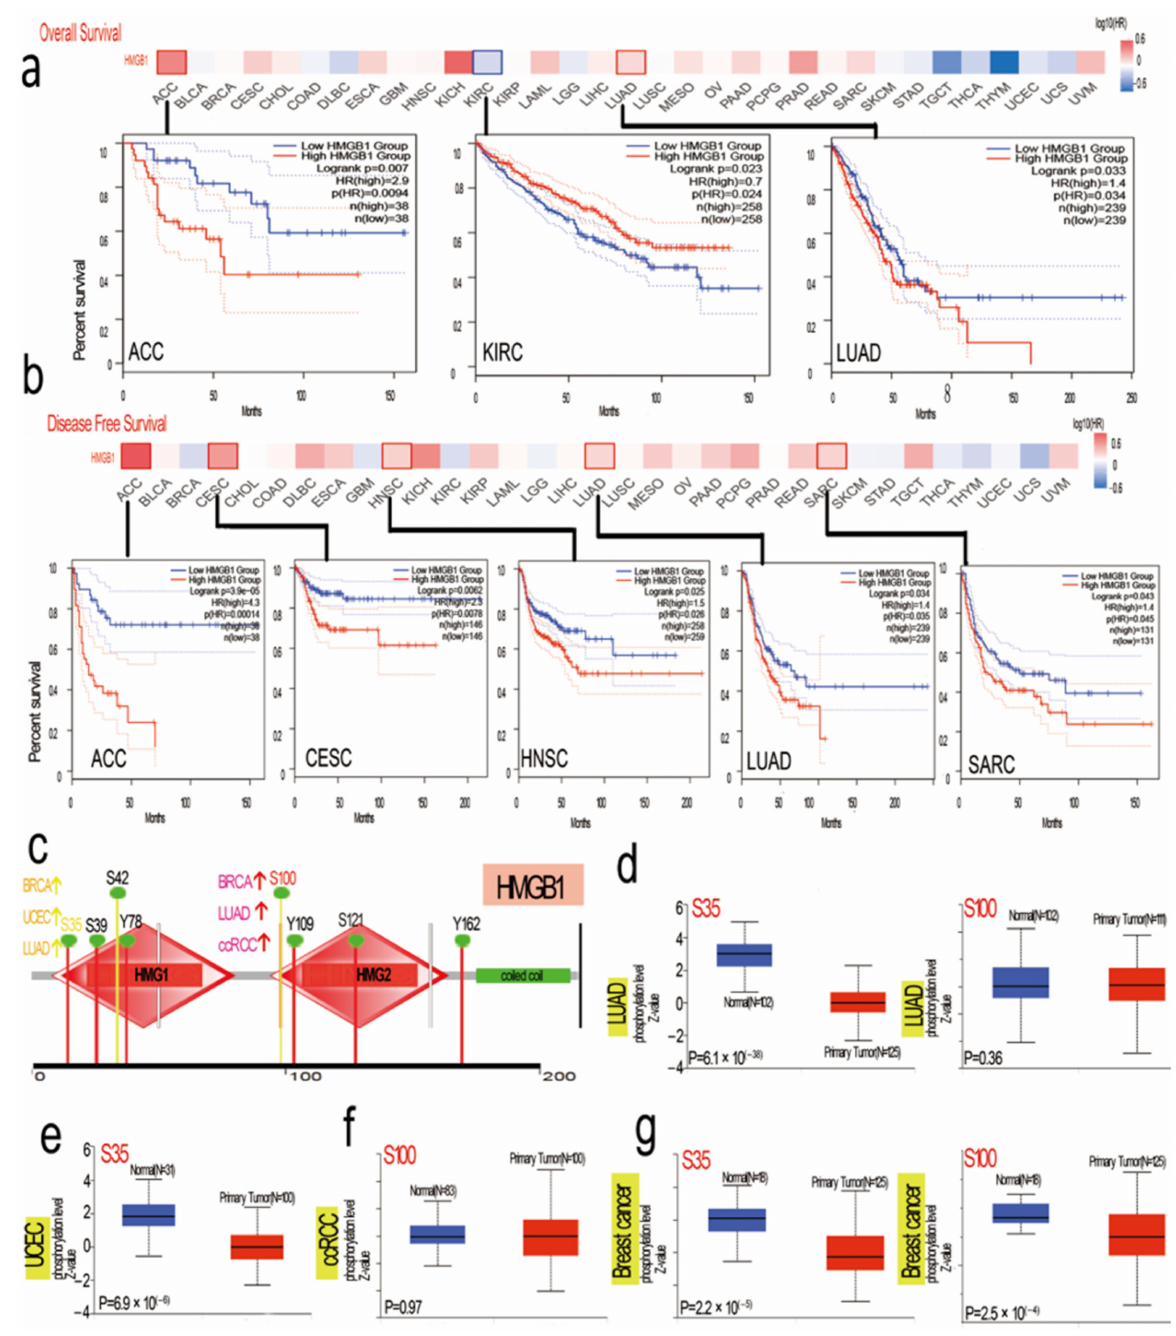
Figure 3. HMGB1-related gene expression and cancer survival prognosis and HMGB1-related protein phosphorylation analysis based on data from the TCGA database. ( a ) Overall survival with HMGB1 expression. ( b ) HMGB1-related disease-free survival. ( c ) HMGB1 phosphorylated protein (S15, T22, S35, S42, T51, S100, Y109, S121 and Y162 sites) in normal tissue and primary tissue. ( d ) LUAD ( e ) UCEC ( f ) clear cell RCC and ( g ) breast